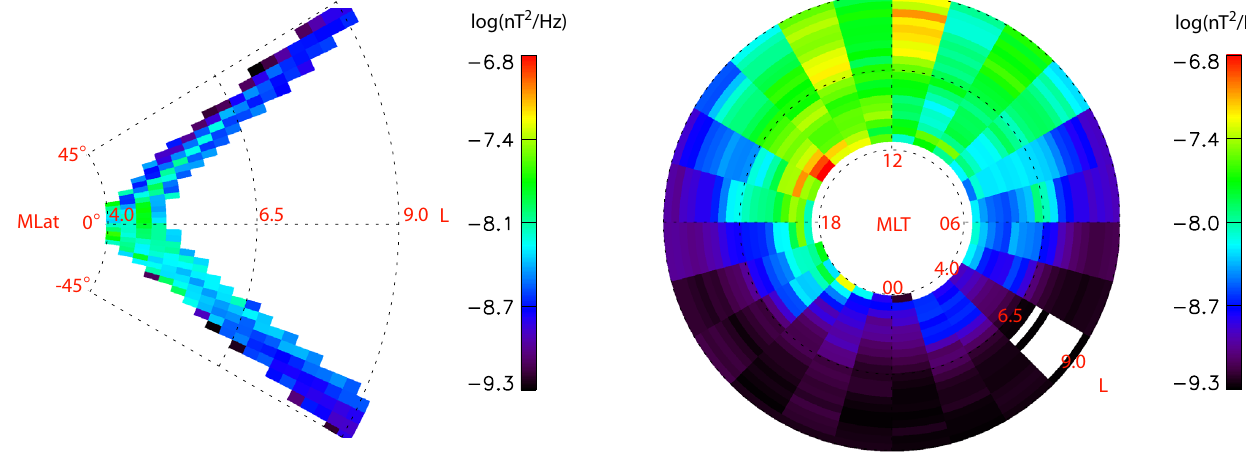
Fig. 2. Distribution of the spectral density in the frequency range 0 . 02 ≤ f/f ce < 0 . 1 dominated by plasmaspheric